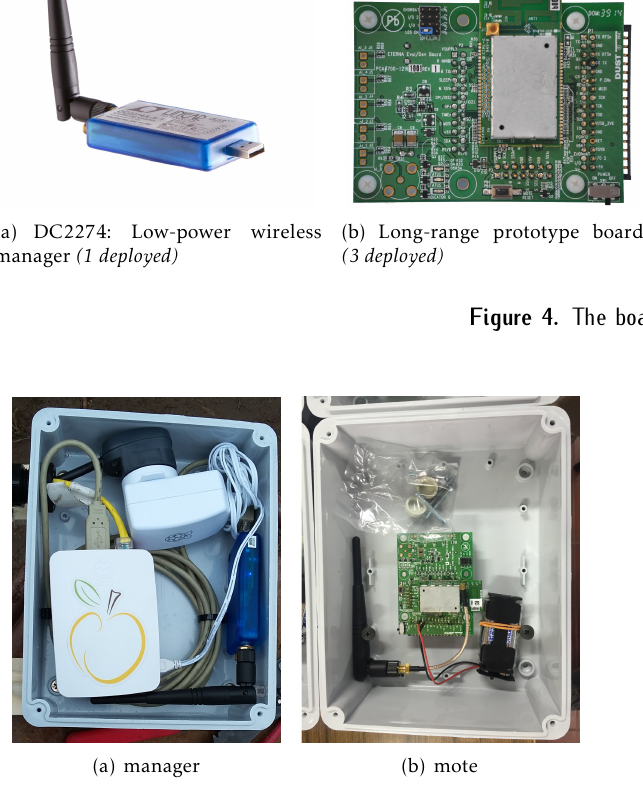
Figure 5. The devices encased in 20 cm × 15 cm IP65 enclosures.